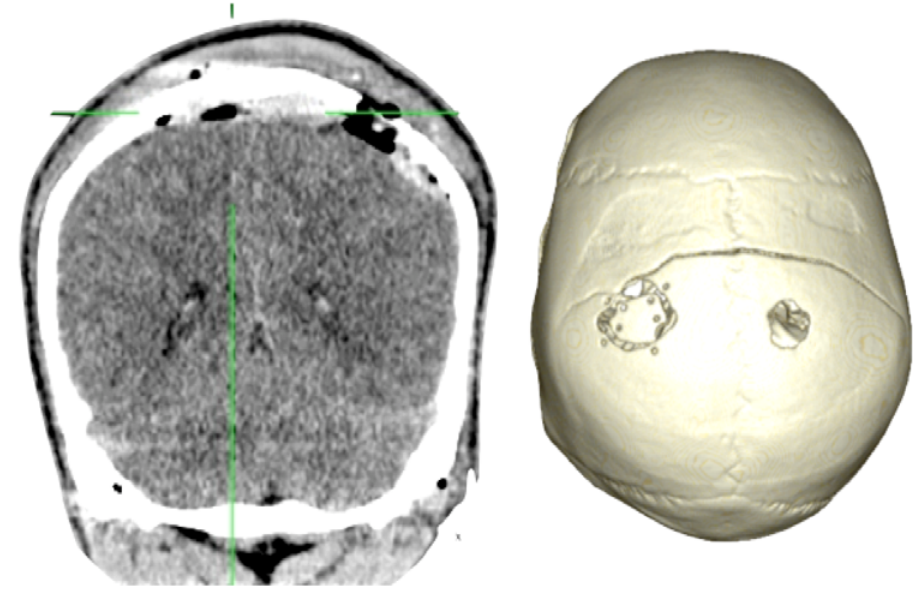
Figure 2. CASE 1. Post-operative results. We performed a combined access to this hematoma. An incision of 3 cm and a 2.5 cm craniotomy was used to resect the largest right component. An incision of 1.5 cm and a burr-hole was used to resect the left component. The component under the superior sagittal sinus was not resected to prevent possible